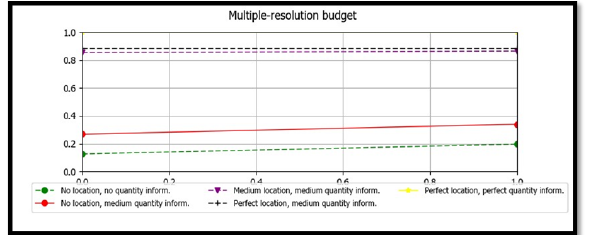
Figure 9: Validation Graph between simulated 2030 and